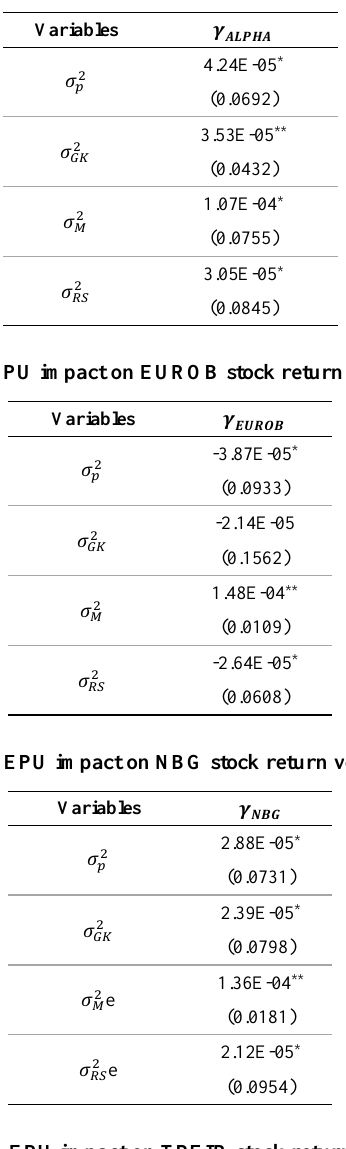
Table 2. EPU impact on ALPHA stock return volatility